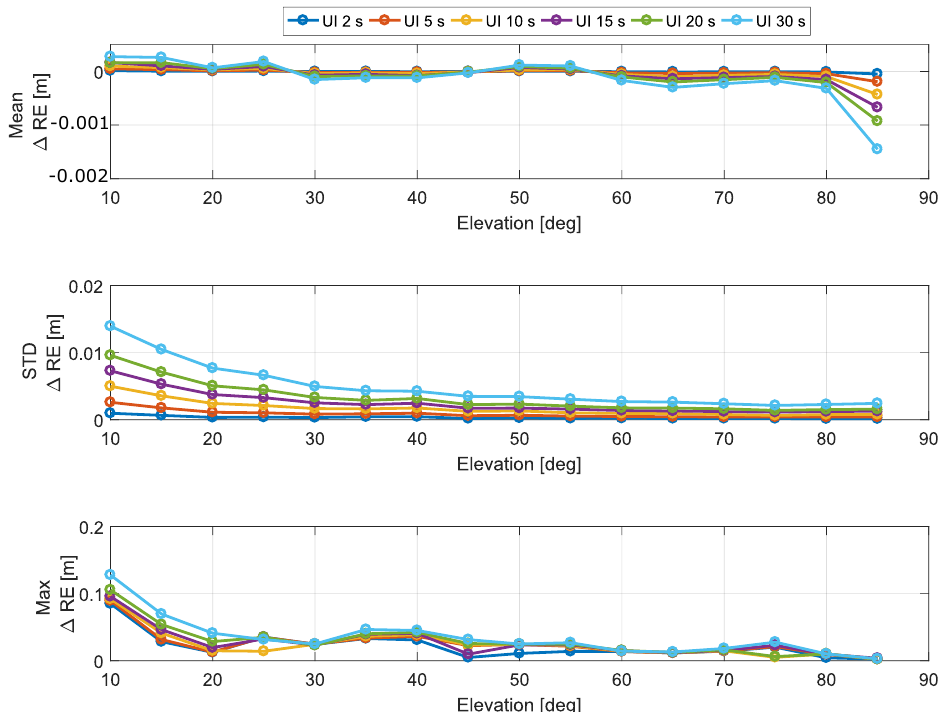
Figure 9. Statistical parameters of the RE differences as a function of the elevation angle. In the legend, “UI” stands for “Update